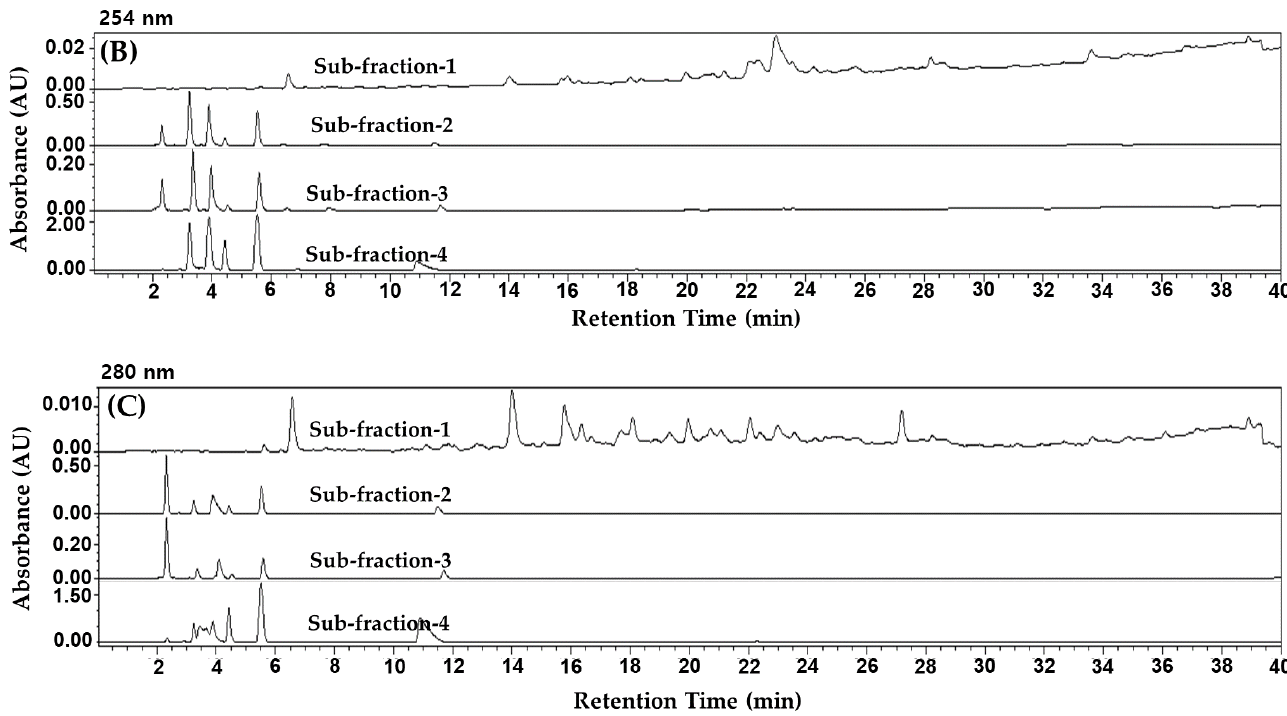
Figure 1. M. lusoria protamex hydrolysate (MLPH): ( A ) DPPH radical scavenging activity of all sub-fractions, ( B, C ) RP-HPLC patterns of sub-fractions monitored at 254 nm and 280 nm, respectively. Each value represents the mean ± SEM in triplicate ( n = 3). a-i Values not sharing a common letter are significantly different at p < 0.05 by Tukey’s multiple comparison test.